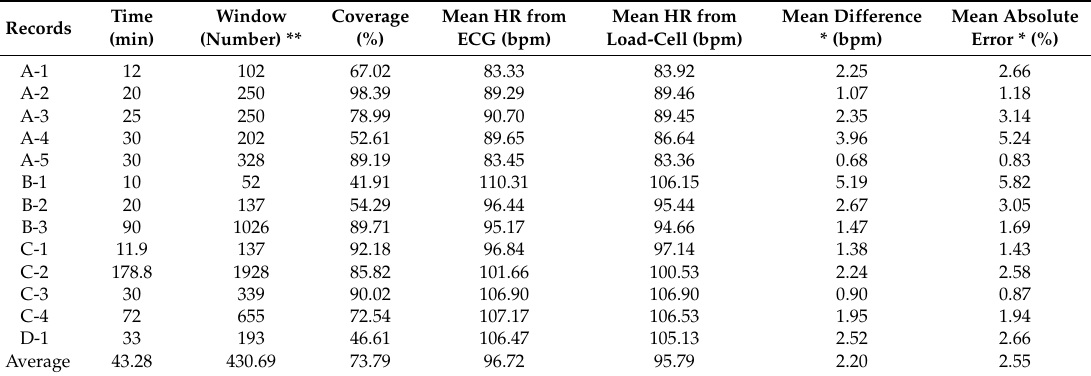
Table 5. Comparison of HRs calculated from commercial device and proposed device.